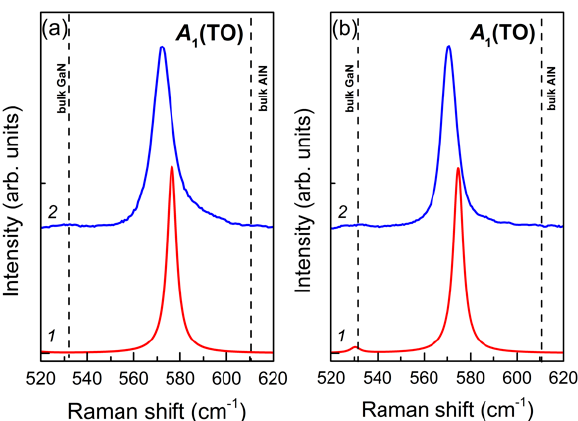
Figure 8. Calculated ( 1 ) and experimental ( 2 ) Raman spectra of (GaN) m /(AlN) n SLs in the x ( zz ) x scattering geometry in the region of A 1 (TO) modes, m / n : 4/4 ( a ), 6/6 ( b ). It can be seen that the calculation quite accurately reproduces the experimentally observed spectral curves with a slight systematic overestimation of the frequency mag- nitude by about 5 cm − 1 . The calculation also confirms the delocalized nature of these modes (see Figure 9). Analysis of the calculated eigenvectors of these modes allows us to understand the nature of their high intensity in the spectra. The pattern of atomic displacements is similar to that of the TO modes in pure crystals, and the amplitudes of both cations and anions in all layers are approximately the same.